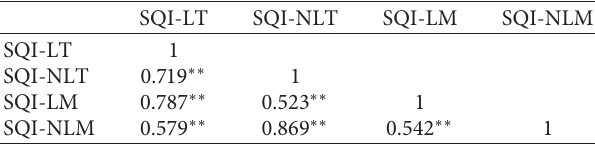
Figure 2: TDS and MDS’ linear scoring (a) and nonlinear scoring (b) approaches utilized to compute the relationships between the indexes of soil quality. Table 7: Correlations between the indexes of the four soil